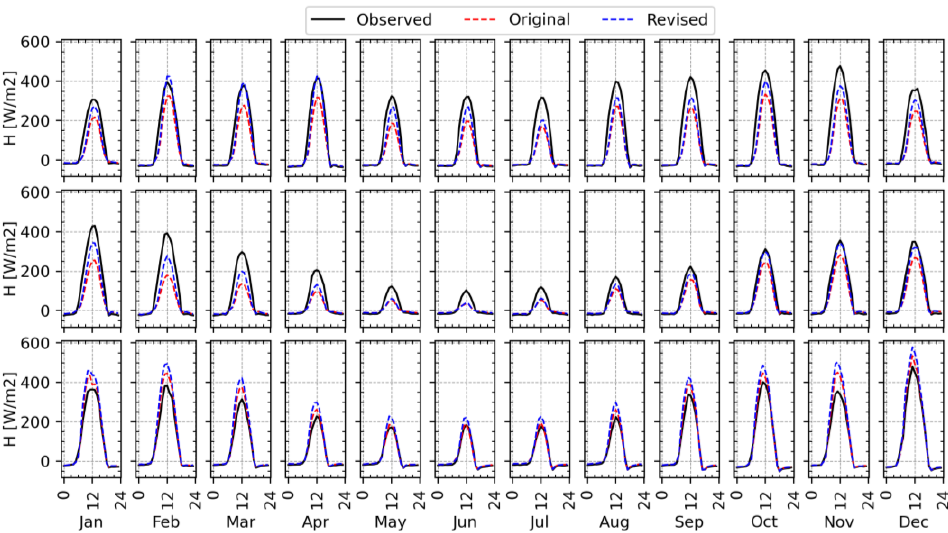
Figure 1. Time-averaged diurnal variations in the observed sensible heat flux versus sensible heat flux simulated with the original and the improved parameterization at savannah sites. The top row corresponds to the Alice Springs site in Australia (AU-ASM), the middle row to the Calperum site in Australia (AU-Cpr), and the bottom row to the Great Western Woodlands site in Australia (AU-GWW).